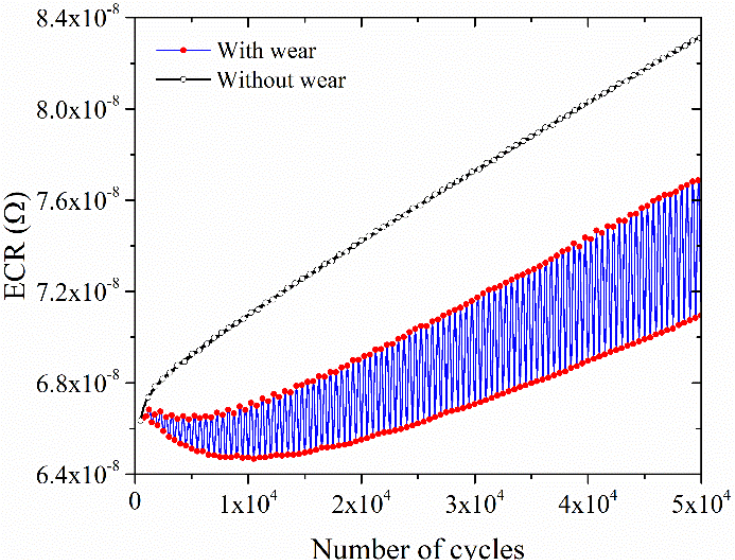
Figure 10. Evolution of the ECR with and without the consideration of fretting wear.